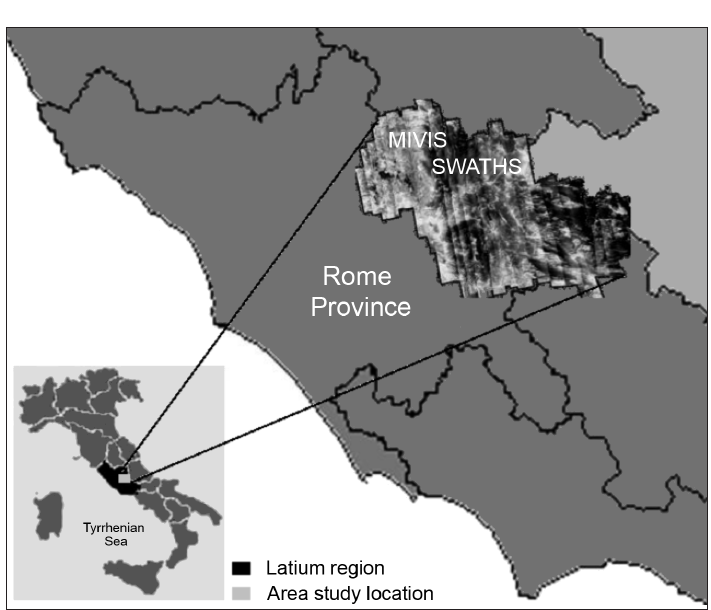
Fig. 1. Location of the study area on Rome Province with MIVIS swaths